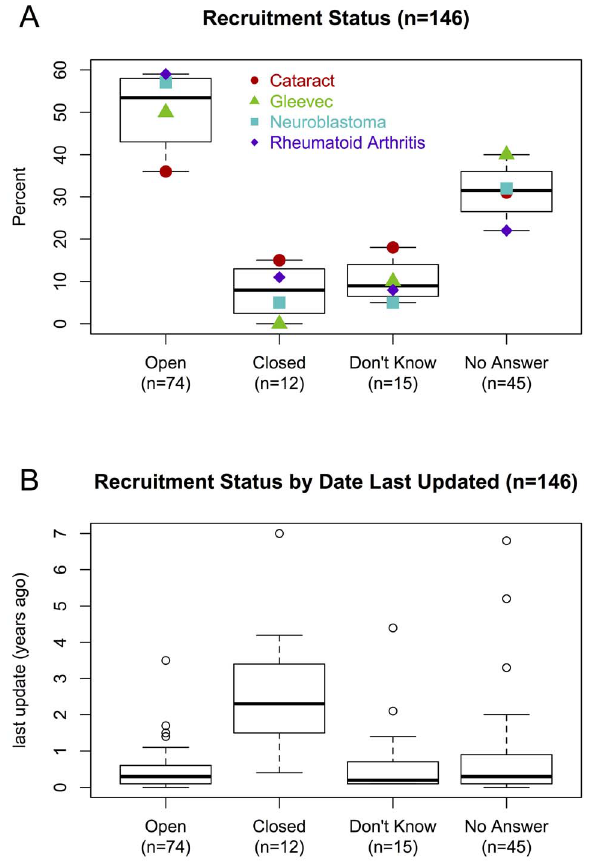
Figure 3. Effective recruitment status. A) Recruitment status (x- axis), verified by phone or email, of the trials in our 4 trial sets. B) The same recruitment status compared against how long ago the trials were last updated on ClinicalTrials.gov. Trials closed for recruitment tended not to have been updated recently when compared to trials open for recruitment (p ,